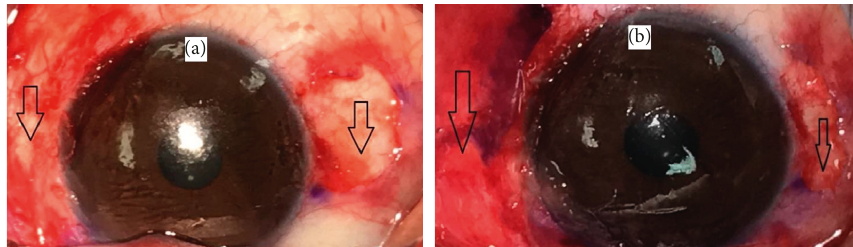
Figure 2: External photograph of case 3 of double-headed pterygium surgery. (a) The conjunctival defects (arrow) after double-headed pterygia excision. (b) The conjunctival autograft